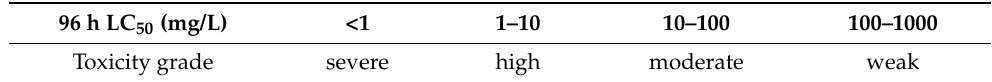
Table 1. Hazard ranking of acute